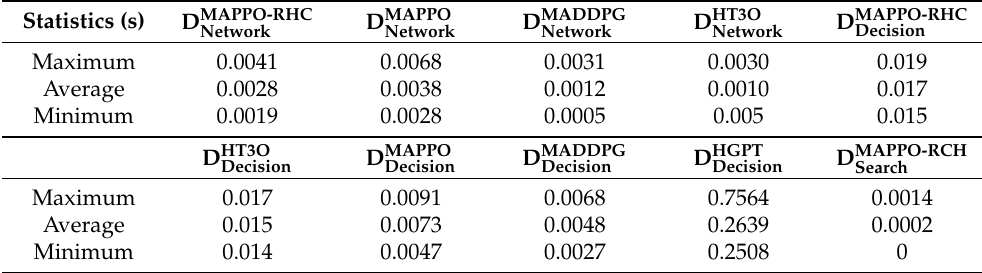
Table 2. Algorithmic calculation